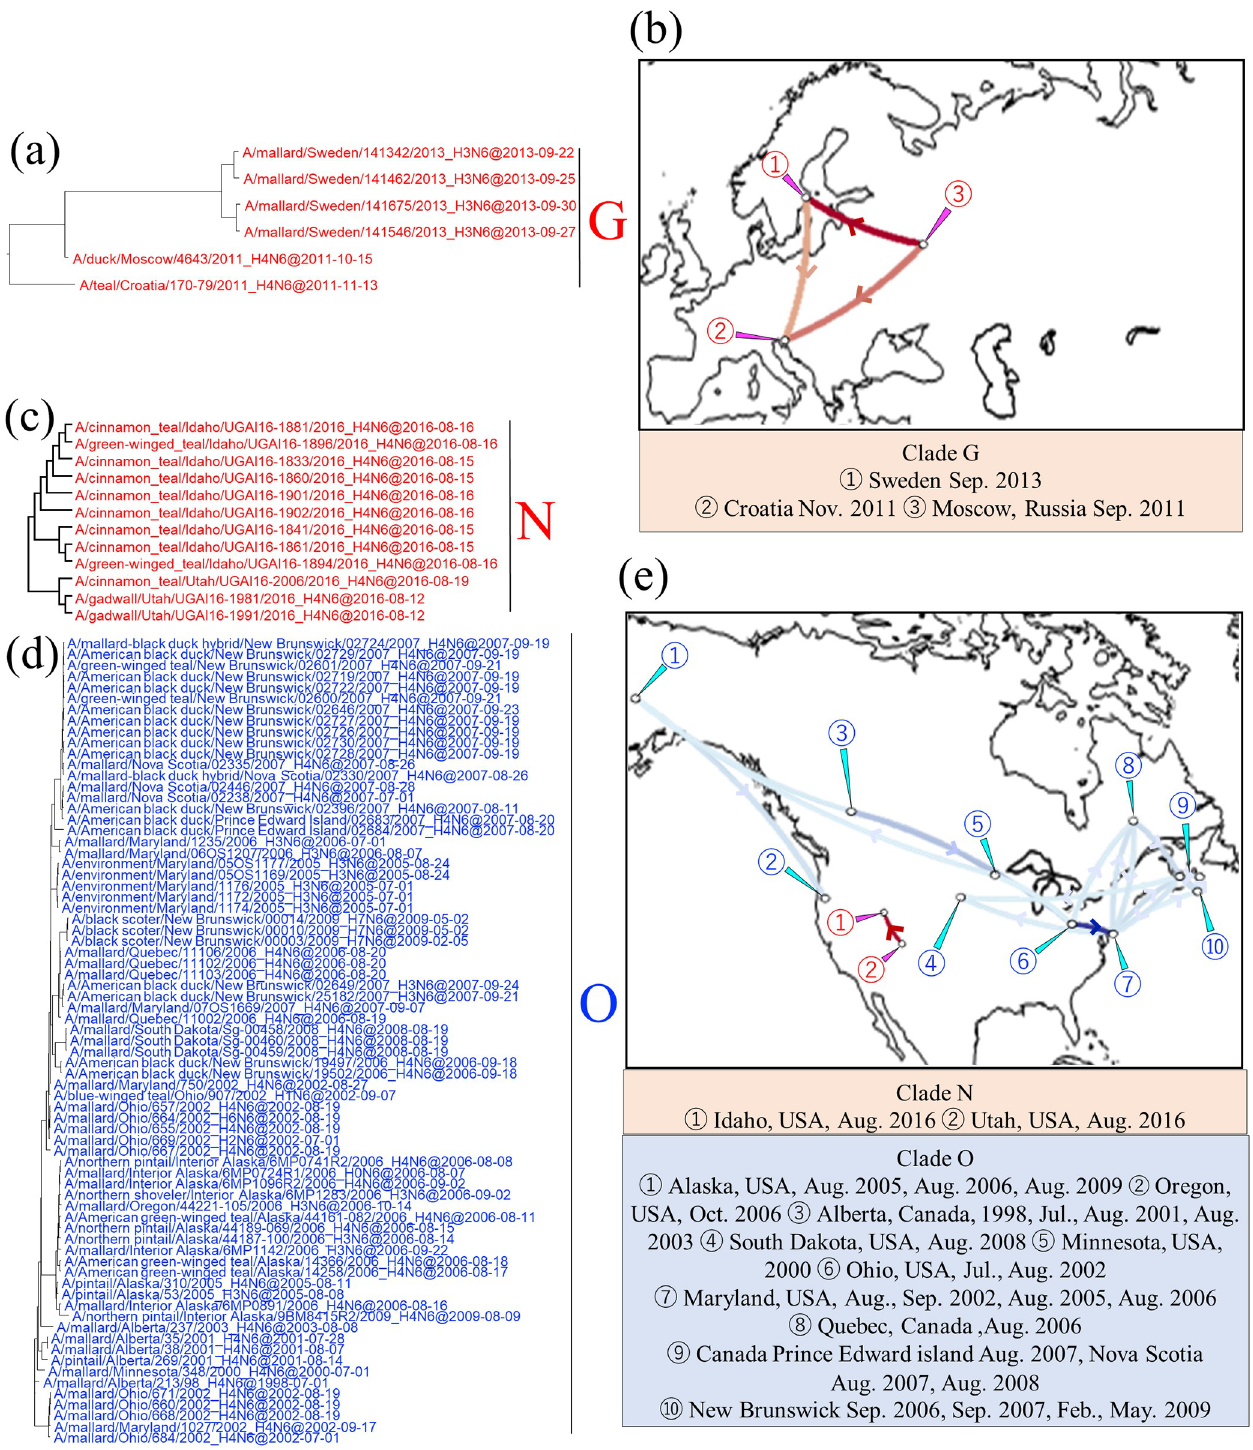
Fig 5. Detail of maximum clade credibility (MCC) phylogenetic trees of N6 NA genes in clades G, N, and O and visualized location-annotated MCC trees for selected clades on the world map. Clade G is red type in the tree (a), and colored type lines in (b) correspond to the clade. Clades N and O are red type and blue type, respectively, in each tree (c and d), and colored type lines in (e) correspond to those of the clade. Lines with Bayes factors of 3.0 or more are shown in the map, and a deeper color means a higher Bayes factor.